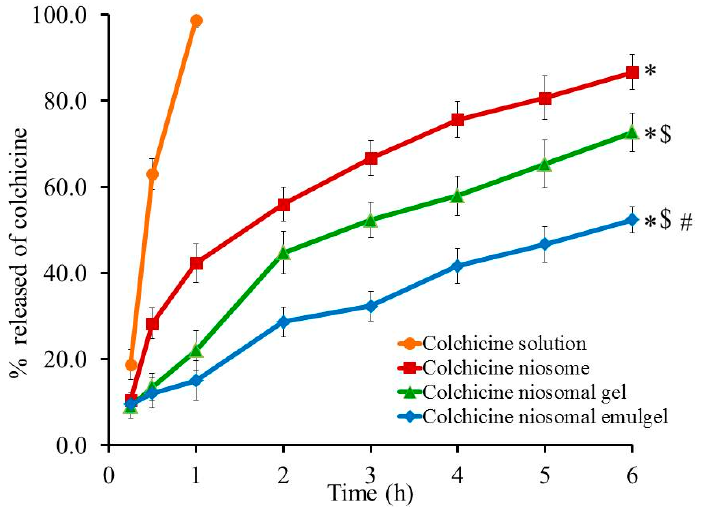
Figure 10. In vitro release study of colchicine from different formulations compared to colchicine solution in phosphate buffer pH 7.4 at 37 °C. Results are expressed as the mean ± SD of three experiments. * p < 0.05 compared to colchicine solution; $ p < 0.05 compared to colchicine niosome and # p < 0.05 compared to colchicine niosomal gel.